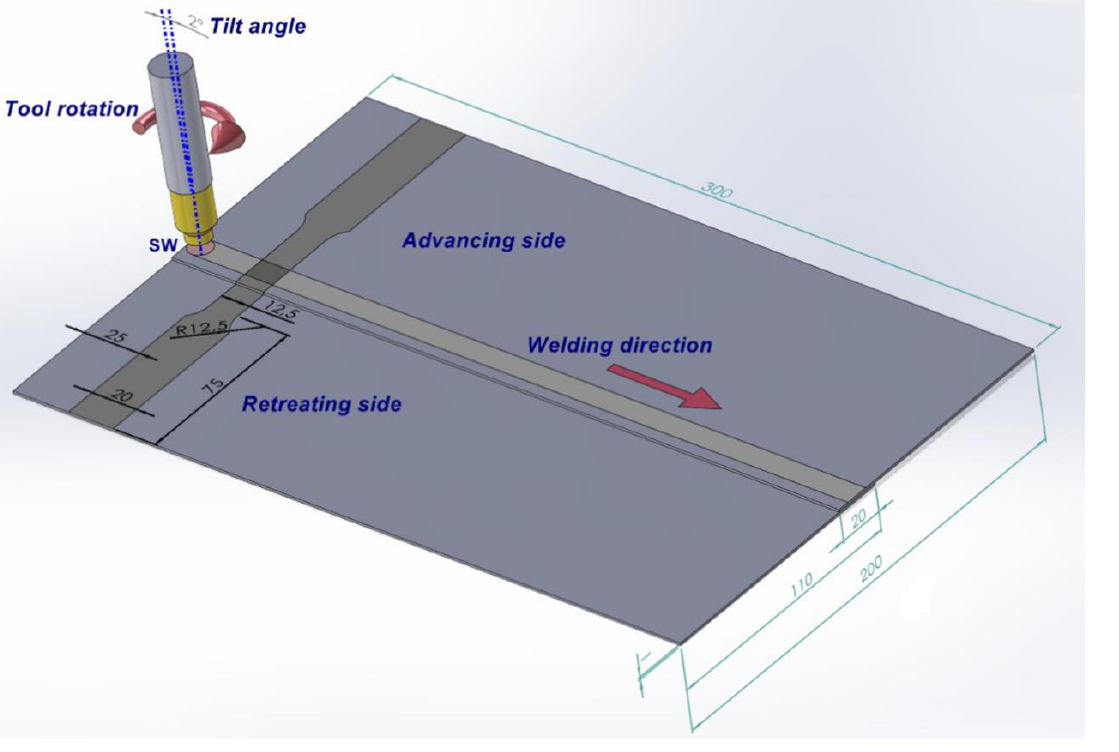
Figure 1. Configuration of the welded panels (unit: mm).